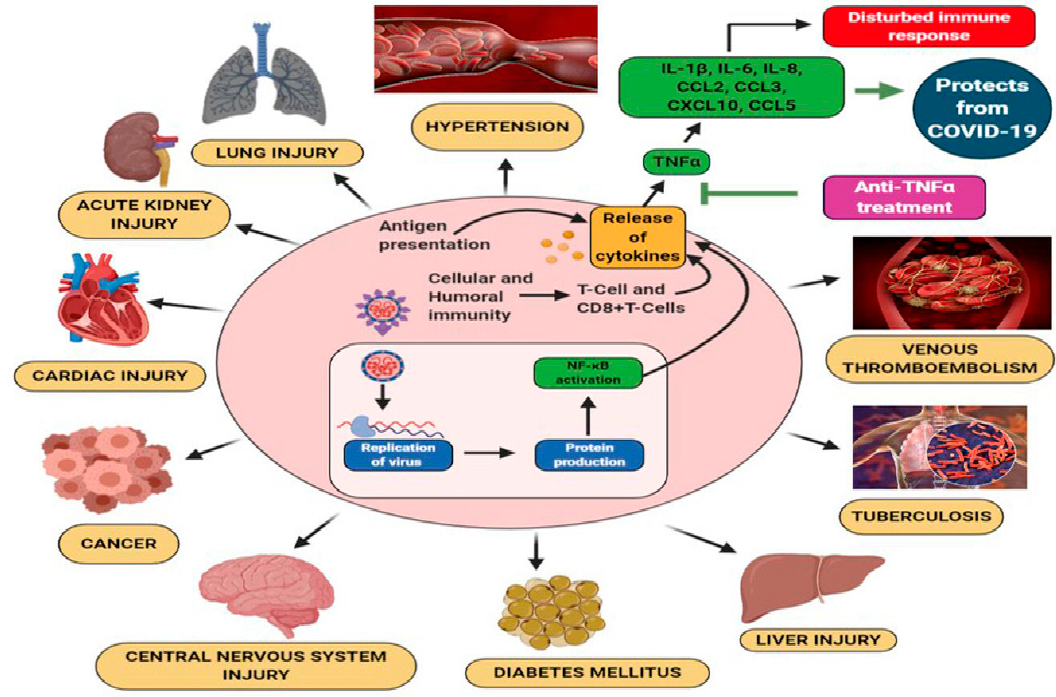
Figure 2. Coronaviruses pathogenesis, comorbidities and multi-organ damage [31].